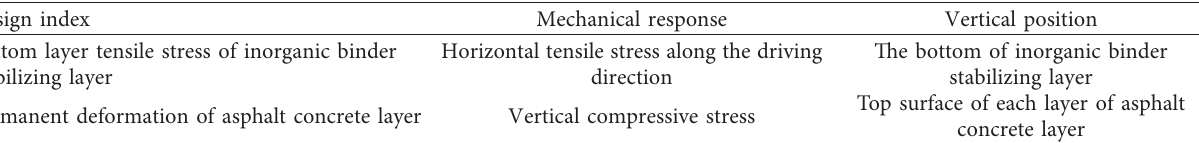
Table 2: The mechanical response corresponding to each design index and its vertical position.